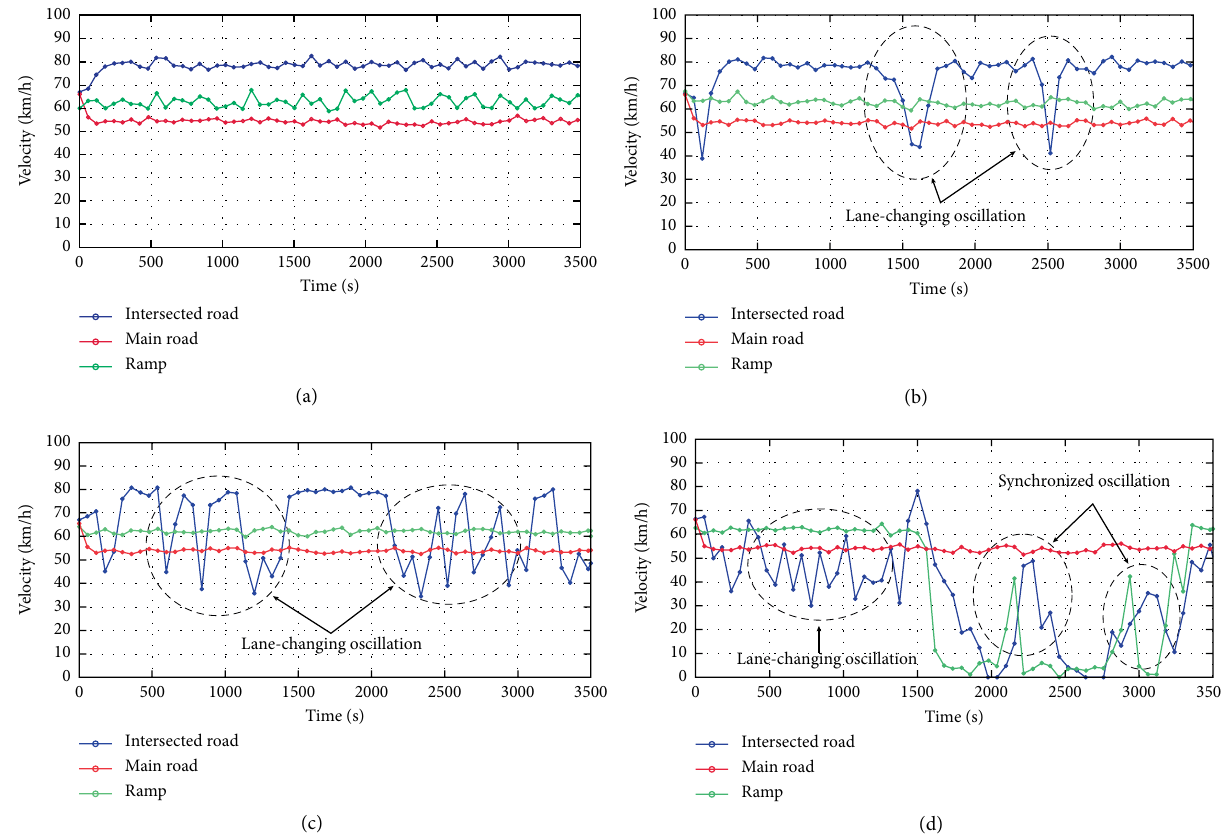
veh / h ∗ l , veh / h ∗ l , 𝑄 veh / h ∗ l , 𝑄 veh / h ∗ l , (b) 𝑄 in = 300 main = 1868 main = 1868 in = 100